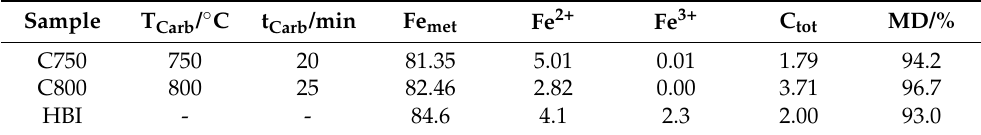
Table 3. Carburizing conditions and composition of the DRI and HBI samples/species in wt.%.